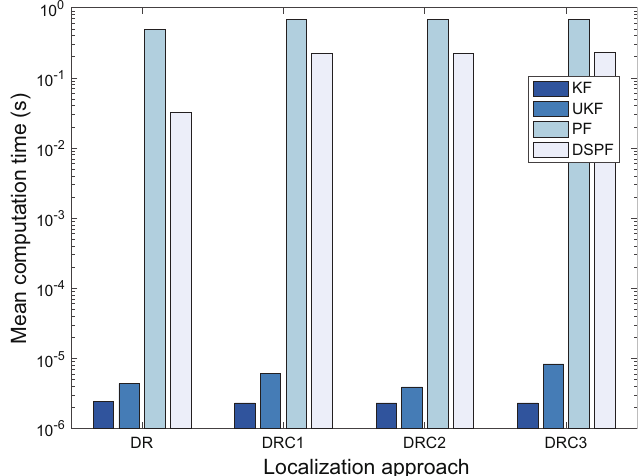
Figure 10. Mean computation time of localization